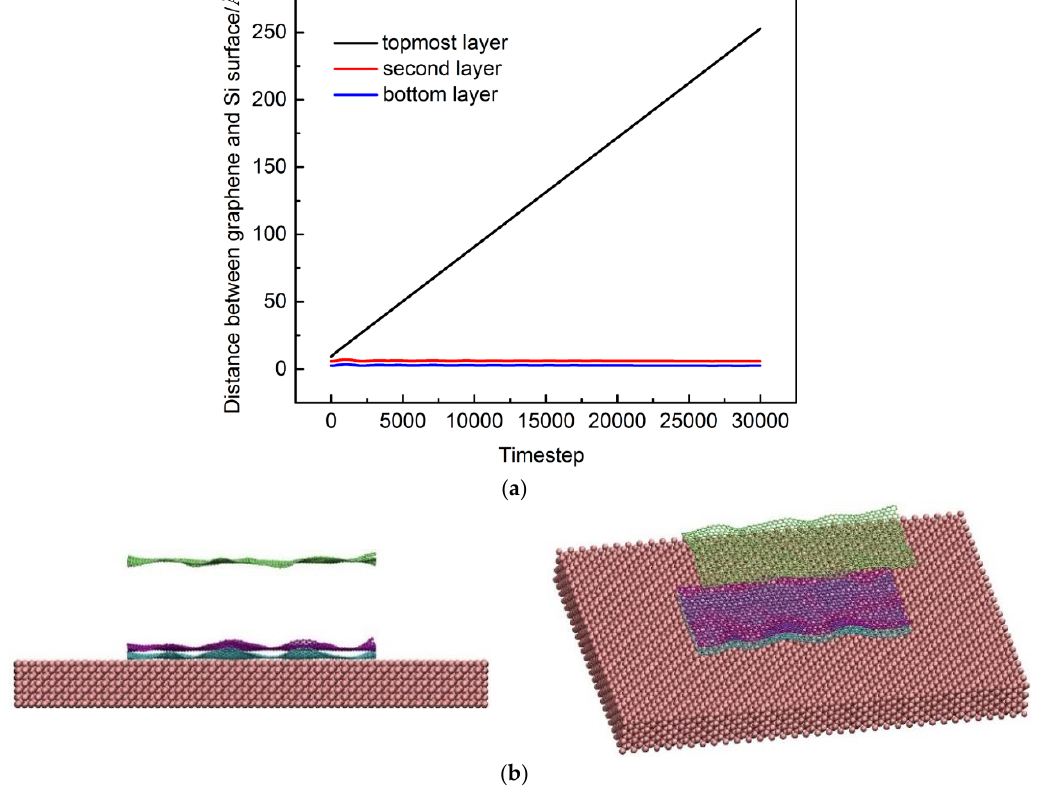
Figure 6. Adhesion behavior in a three-layer graphene system, when the vertical upward velocity is 12 Å /ps: ( a ) The variation of distance between graphene and the Si substrate surface with timestep; ( b ) atomic trajectory of the three-layer graphene system.